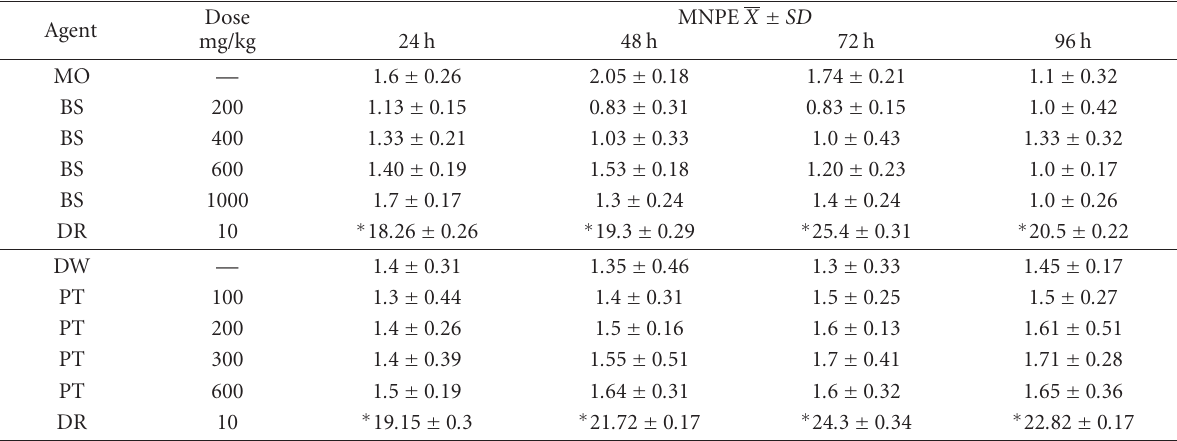
Table 2. Frequency of micronucleated polychromatic erythrocytes (MNPE) induced by beta-sitosterol (BS) and pteropodine (PT) in mouse blood cells. MO = mineral oil (0.4mL added to each mouse). DW = distilled water (0.4 mL added to each mouse). DR =